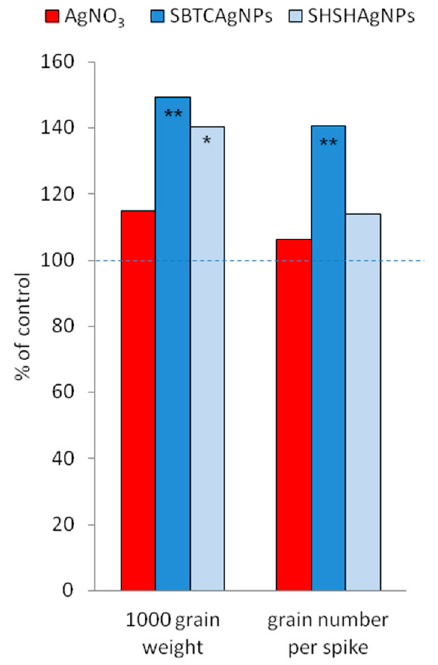
Figure 5. Yield-related parameters of the control and the AgNO 3 -, SBTCAgNPs- and SHSHAgNPs-treated wheat plants shown as percentages of the control plants (100%). Significant differences to the control are given by asterisks: ** p < 0.01; * p < 0.05.